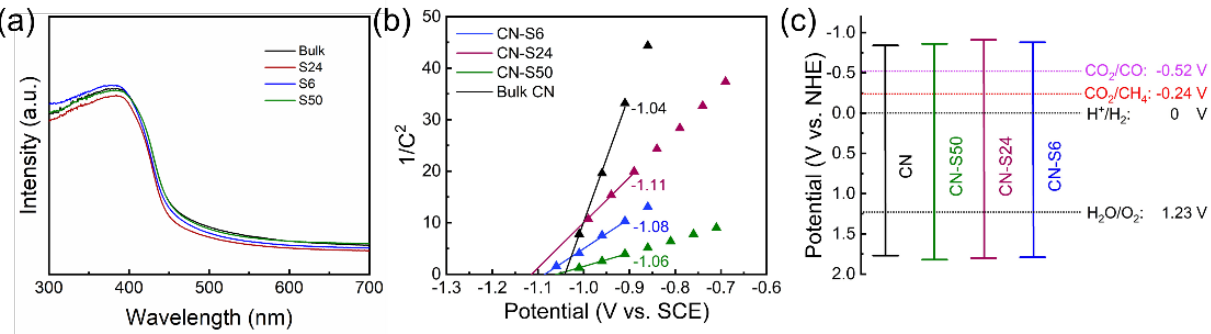
Figure 3. Bandgap characterization of the synthesized CN, CN-S50, CN-S24, and CN-S6 samples: ( a ) UV–vis diffuse reflectance spectra. ( b ) Mott–Schottky plots in a 0.5 M Na 2 SO 4 aqueous solution. ( c ) Calculated bandgaps.